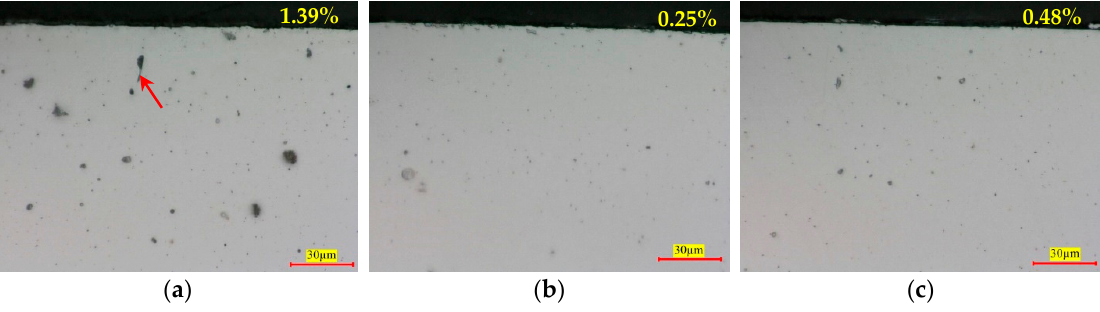
Figure 5. ( a ) Porosity observed on the surface and subsurface of as-built sample ( b ) Machined sample (V c = 50 m/min); ( c ) Machined sample ( V c = 200 m/min).